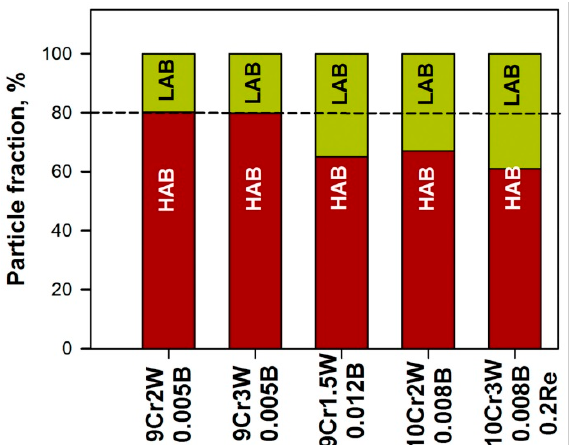
Figure 8. The ratio between the number density of Laves phase particles located at the HABs and LABs after creep times ranging from 454 to 1037 h in the gauge section of crept samples. Table 5. The number particle density and mean size of Laves phase particles located at the high-angle boundaries (numerator) and low-angle boundaries (denominator) in steels after 454–1037 h of creep at 650 ◦ C. Steel Creep